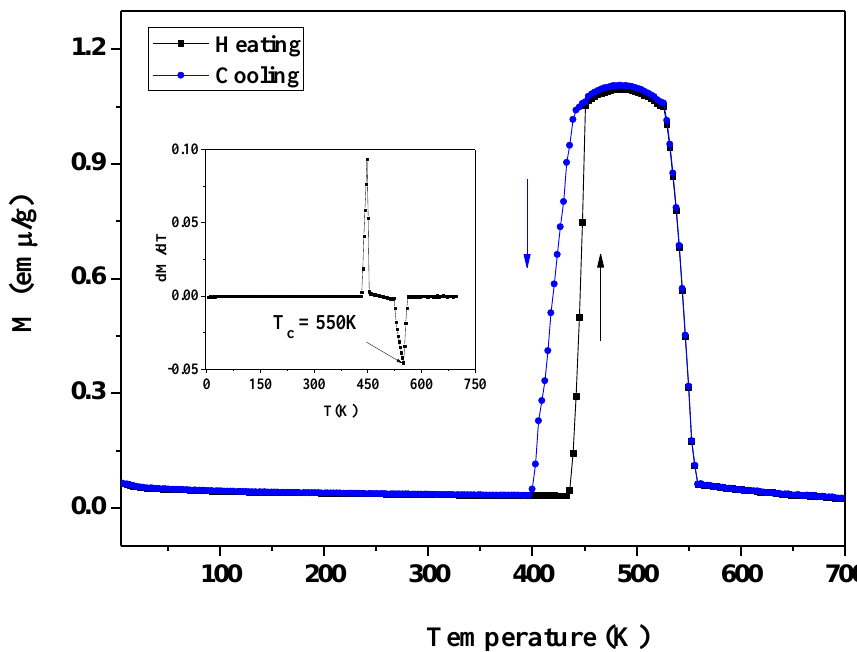
Figure 18. The zero-field-cooled (ZFC) and zero-field-heated (ZFH) temperature dependence of the magnetization under static magnetic fields of 50 mT for the Ni 2 − x Co x In 3 (x = 0.200) alloy.